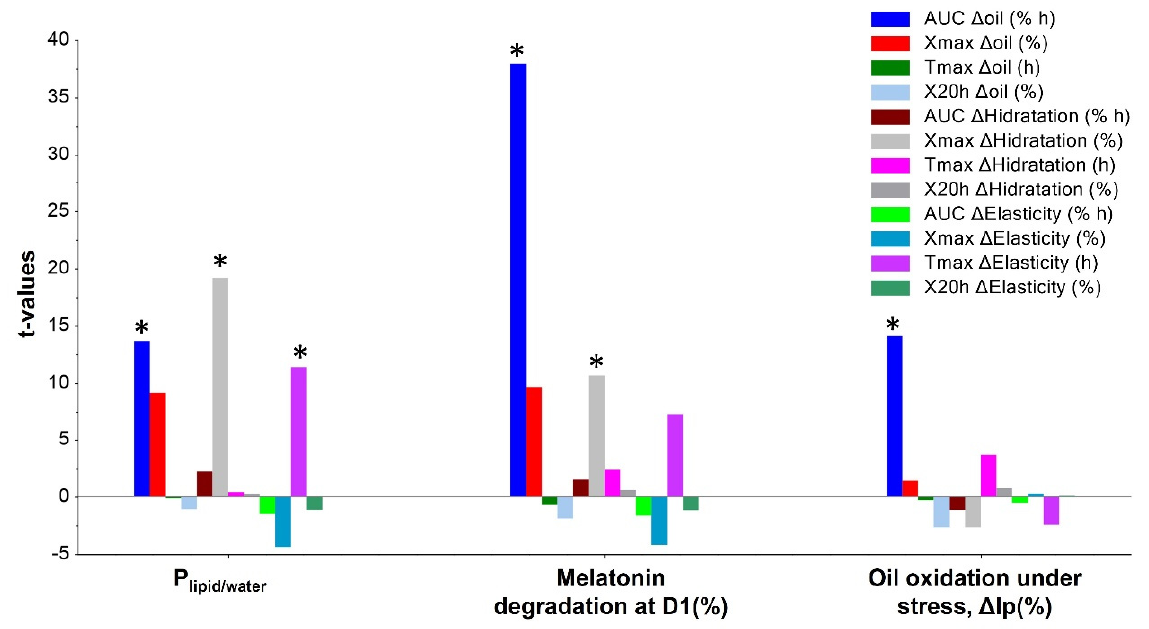
Figure 5. t-values from the MLR analysis of P lipid/water , melatonin degradation at day 1 and oil oxidation under stress (%). Key: * p -value < 0.05.